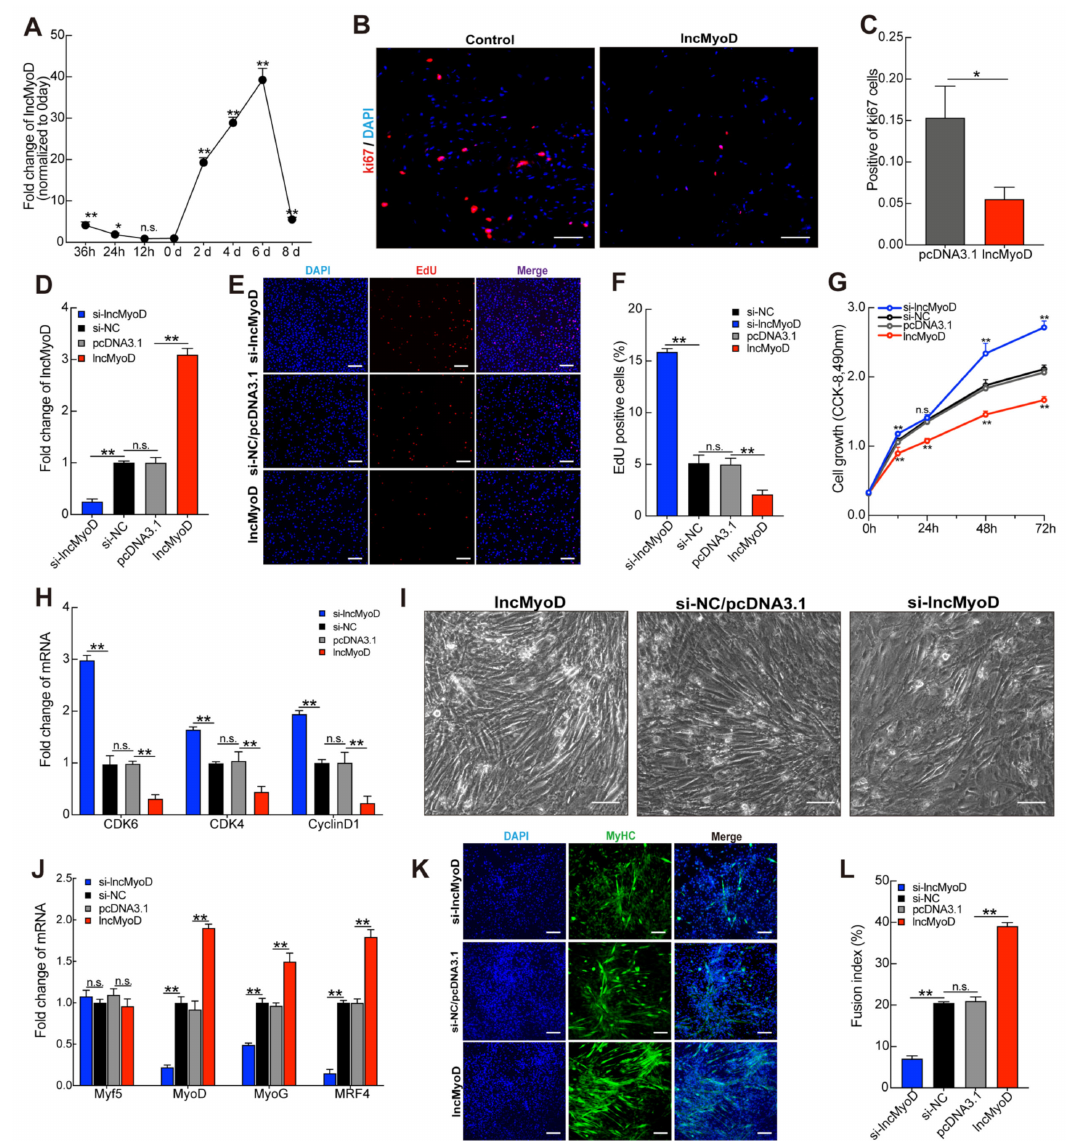
Figure 2. lncMyoD regulate myoblast proliferation and differentiation. ( A ) The expression levels of lncMyoD during C2C12 myoblast proliferation and differentiation. ( B , C ) The ki67 expression levels were obtained by immunofluorescence analysis after mice were injected with pcDNA3.1-lncmyod or pcDNA3.1. ( D )After C2C12 myoblasts in GM (growth medium) were transfected with synthesized lncMyoD (pcDNA3.1-lncMyoD), pcDNA3.1, si-lncMyoD, and si-NC, the EdU proliferation assay ( E , F ) and CCK-8 assay ( G ) were used to determine cell proliferation. ( H ) The expression level of CDK6, CDK4, and cyclinD1 at 24 h of transfection was evaluated by qRT-PCR. ( I ) After transfection for 8 d, C2C12 myoblast differentiation was observed by bright-field microscopy. ( J ) qRT-PCR measured the expression levels of MyoD, MRF4, MyoG, and MyHC. ( K ) Immunofluorescence was used to analyze MyHC, ( L ) fusion index of myotube. Scale bars in ( I ), 100 µ m and in ( B , E , K ) 50 µ m. Data are means ± SD. p -values are obtained from independent-samples t -tests. * p < 0.05, ** p <